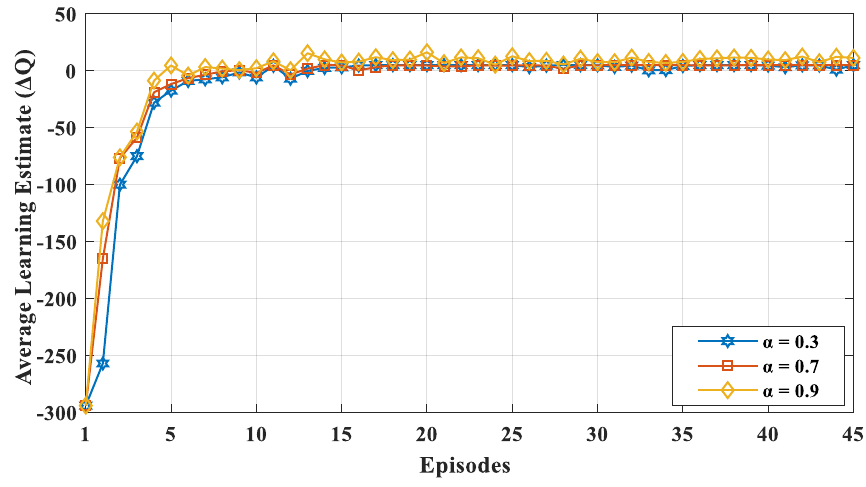
Figure 4. Convergence of learning estimate 𝛥𝑄 for varying the learning rate 𝛼 ( 𝛽 = 0.7, ∊ = 0.7).